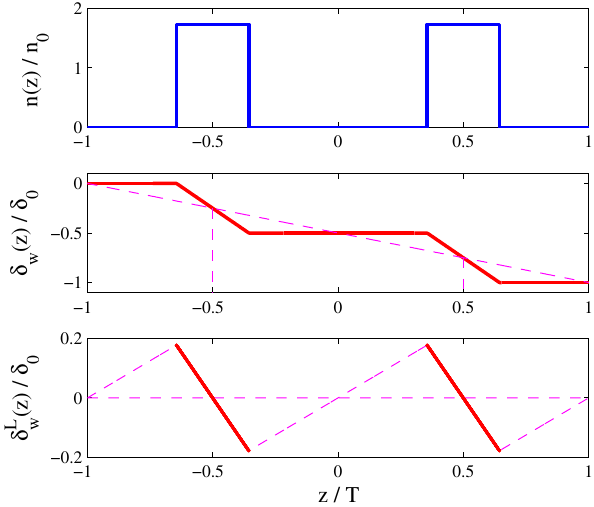
ð z Þ and (down) w